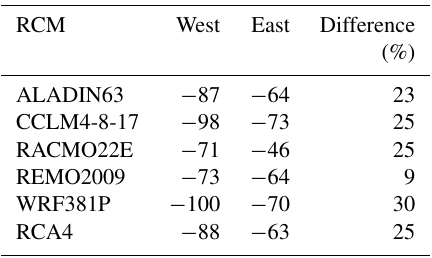
Table 4. Projections of annual series of water discharge by 2100 for each RCM and according to both